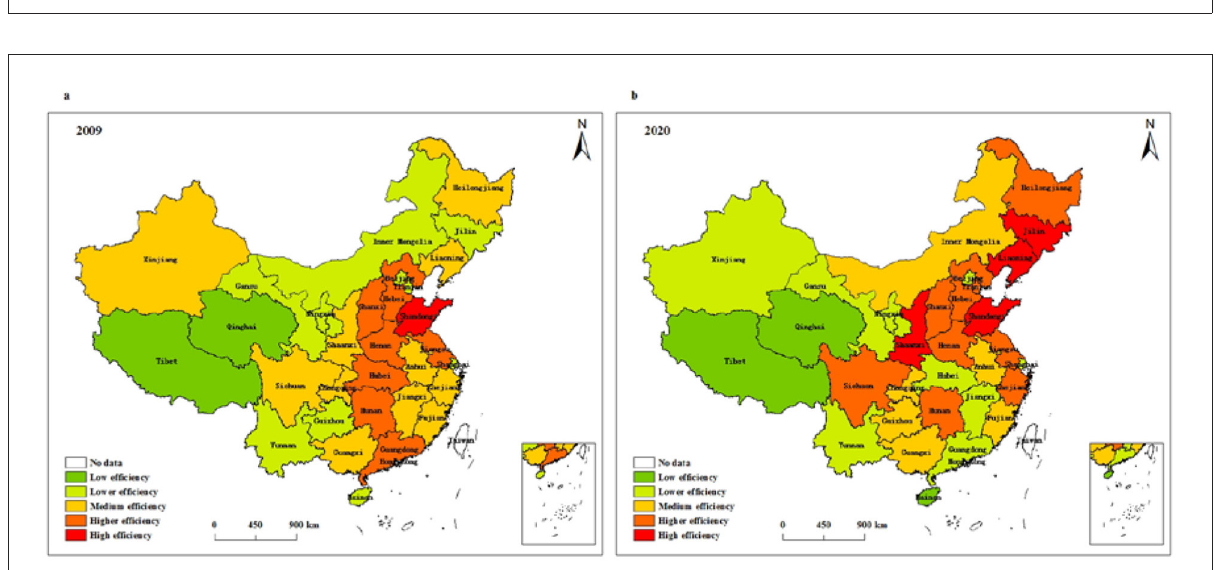
FIGURE6 Spatial pattern of resource allocation efficiency of health systems in (a) 2009 and (b)